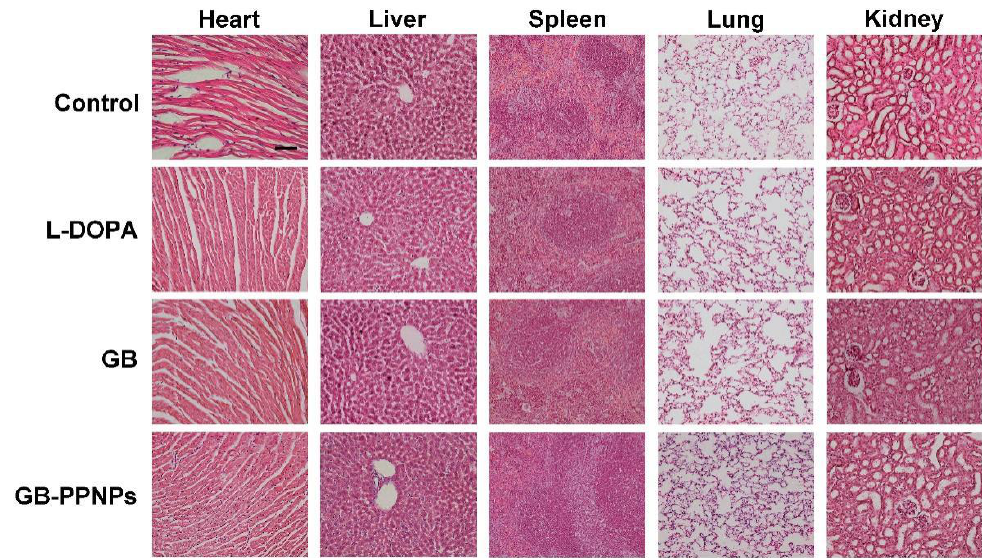
Figure 9. H&E-stained organs in the indicated groups. The scale bar is 50 µ m. Figure 9. H&E- stained organs in the indicated groups. The scale bar is 50 μm.